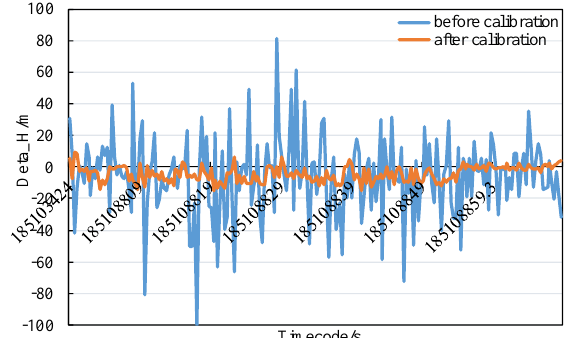
Figure 6. Elevation difference of the153 th track laser data